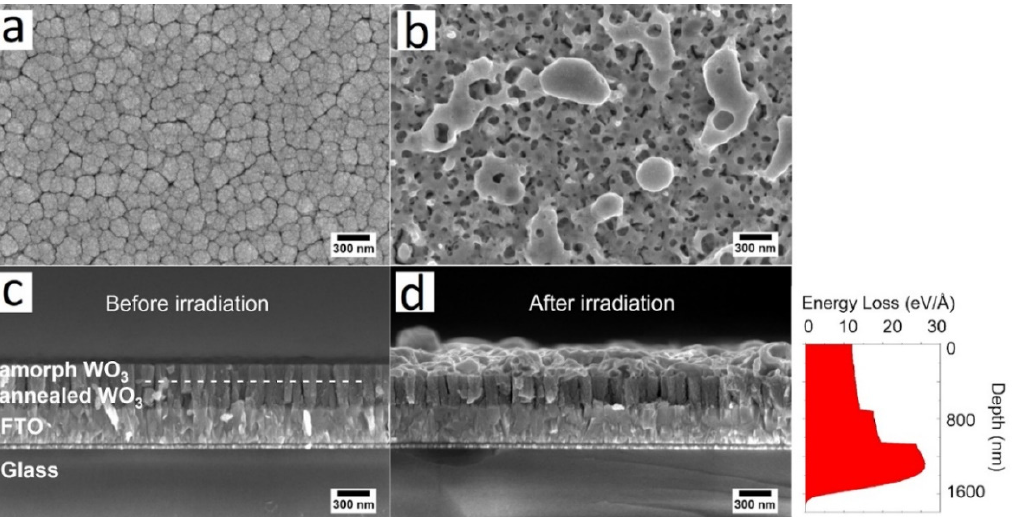
Figure 2. SEM images of surface of ( a ) non-irradiated and ( b ) irradiated double-layer WO 3 at 6 A/cm 2 and cross-sections of ( c ) non-irradiated and ( d ) irradiated double-layer WO 3 at 6 A/cm 2 . Inset—Calculated energy loss cross-section profile of protons with initial kinetic energy of 350 keV.